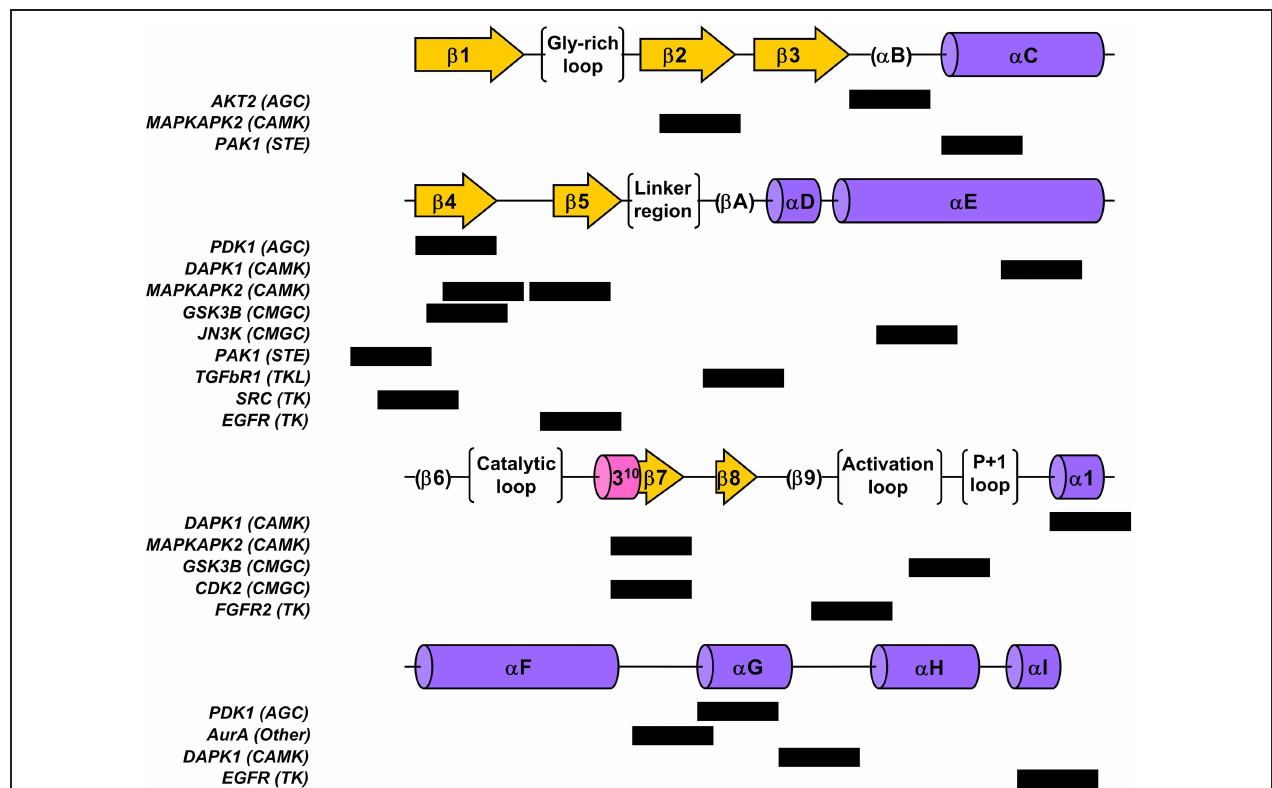
β -sheets are shown as arrows, α -helices as cylinders and other structural or functional features are shown in parenthesis or brackets. Black boxes denote the location of the hexapeptidic pattern found for the corresponding inline domain.